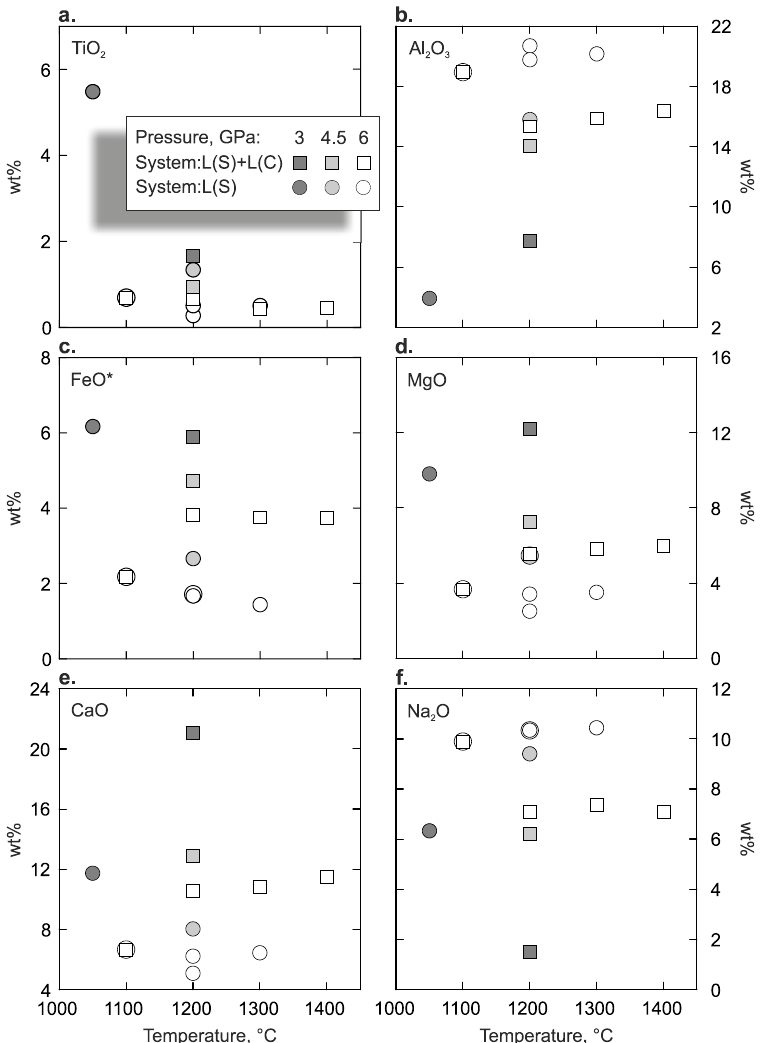
Figure 10. Compositions of clinopyroxene versus temperature. ( a ) TiO 2 , ( b ) Al 2 O 3 , ( c ) FeO, ( d ) MgO, ( e ) CaO, ( f ) Na 2 O. FeO* = total Fe as Fe 2+ .